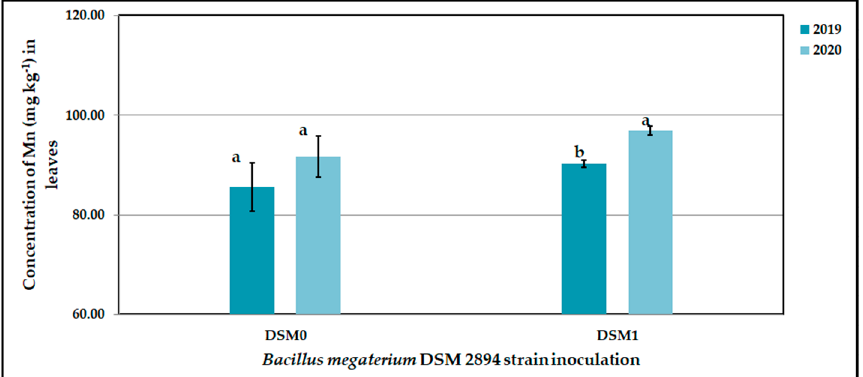
Figure 6. Influence of Bacillus megaterium DSM 2894 var. on leaf manganese (Mn, mg kg − 1 ) contents of CaCO 3 ‐ stressed sweet potato plants in 2019 and 2020 seasons. Bars with a different letter indicate significant difference between treatments at p ≤ 0.05. DSM 0 = non ‐ inoculated with Bacillus megaterium DSM 2894 var., DSM 1 = inoculated with Bacillus megaterium DSM 2894 var.